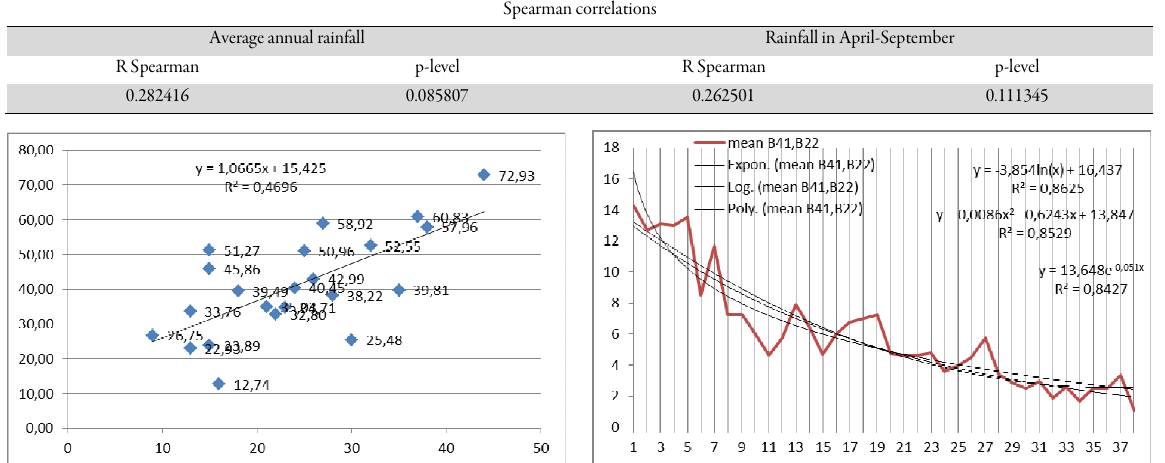
Fig. 1. Correlation between trees age and trunk diameter Fig. 2. Mean increase series in dendro-chronological area